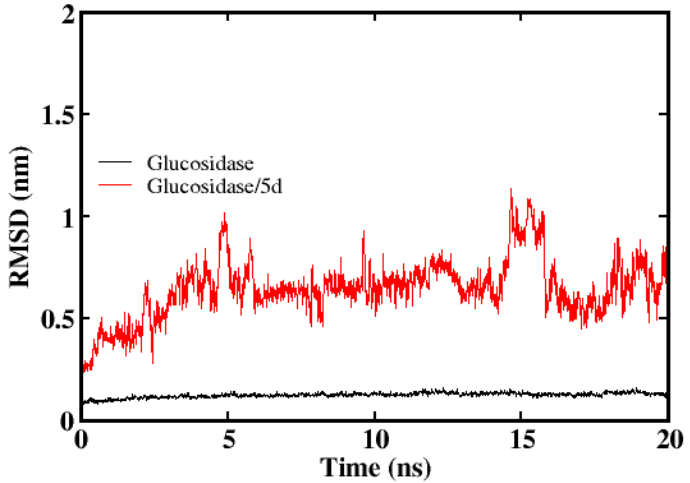
Figure 4. RMSD profile of α-Glucosidase backbone C α atoms (solid lines) and ligand( 5d ) with respect to α-Glucosidase (dash lines) throughout 20 ns simulations.